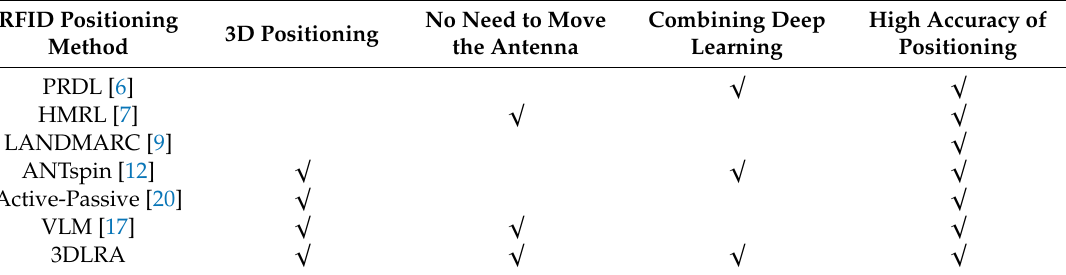
Table 6. Comparisons of RFID positioning